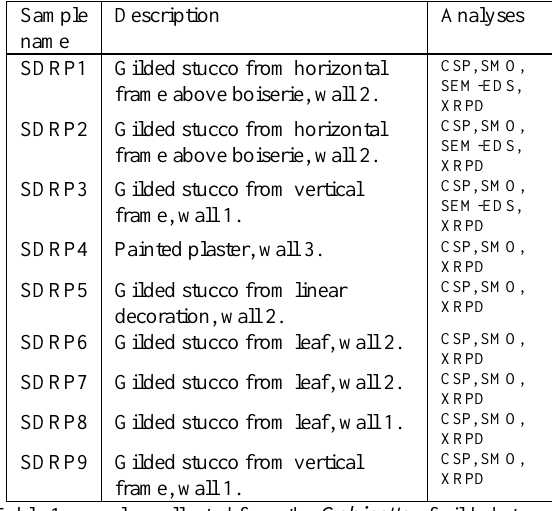
Figure 9. SEM-EDS image of sample SDRP1.